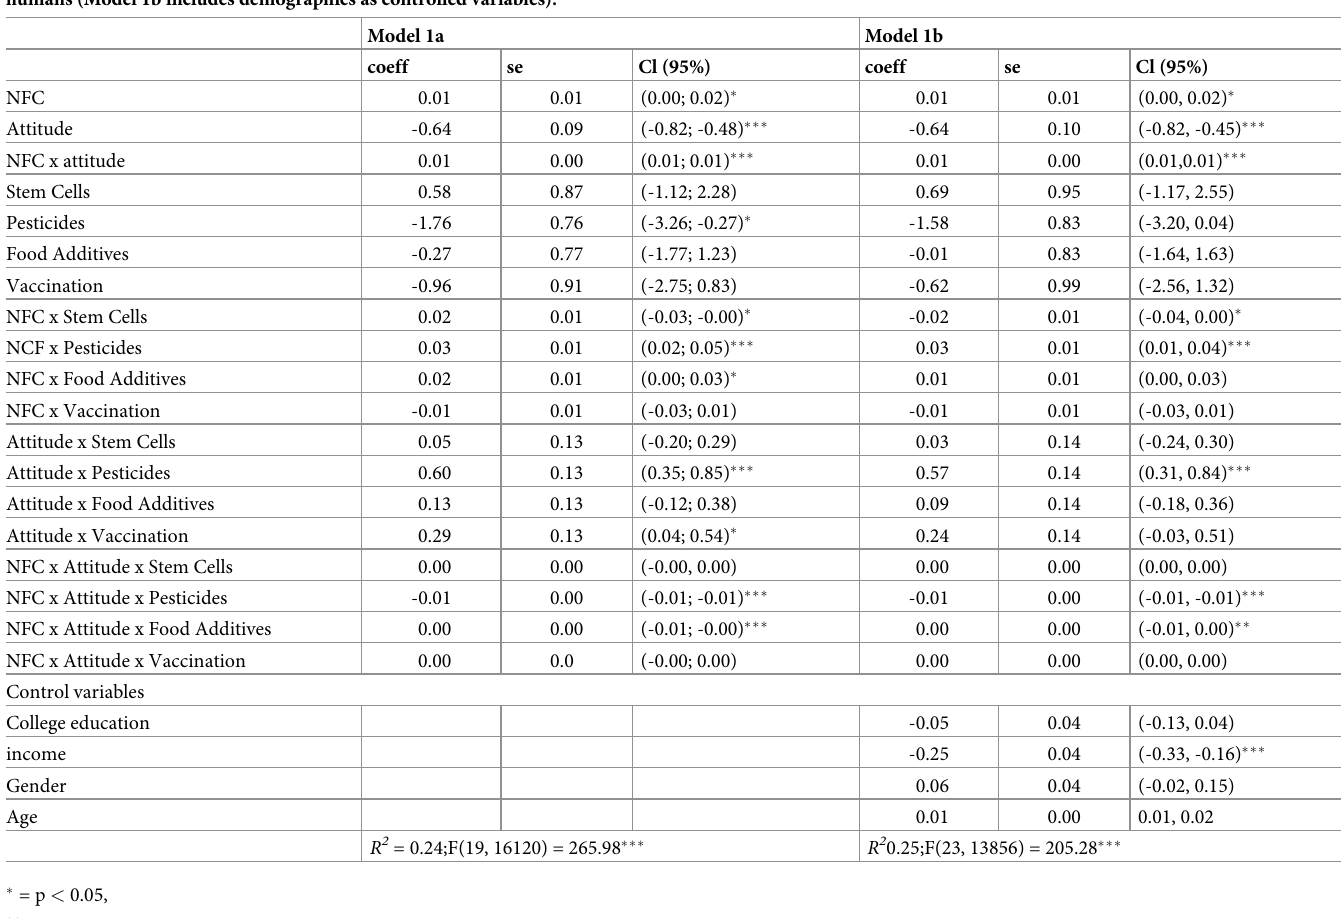
Table 3. Moderated moderation effects of attitude (W) and technology (Z) on the relationship between NFC and distance between perceived harms and benefits for humans (Model 1b includes demographics as controlled